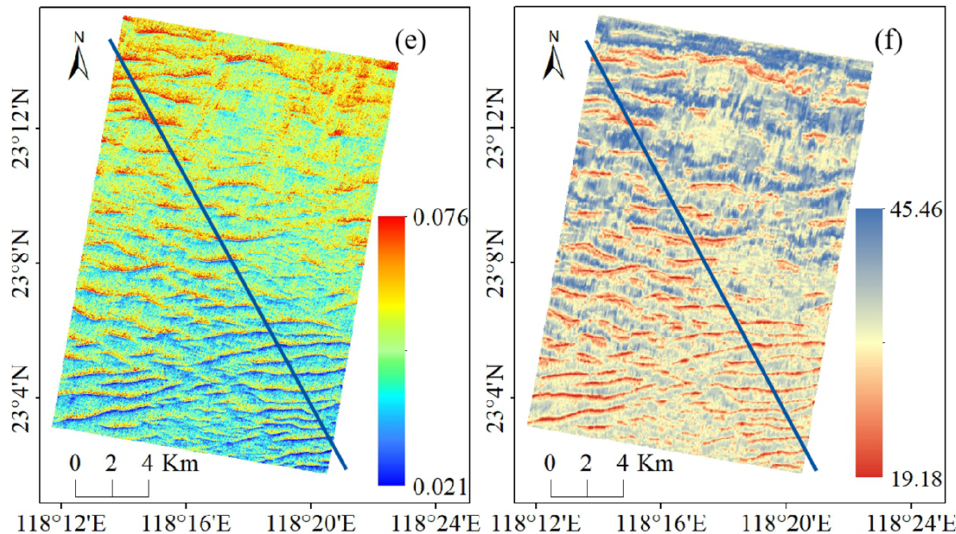
Figure 12. ( a ) Roughness of area A2, ( b ) predicted water depth of area A2, ( c ) roughness of area A3, ( d ) predicted water depth of area A3, ( e ) roughness of area A4, ( f ) predicted water depth of area A4. Blue lines indicate measured profile lines.